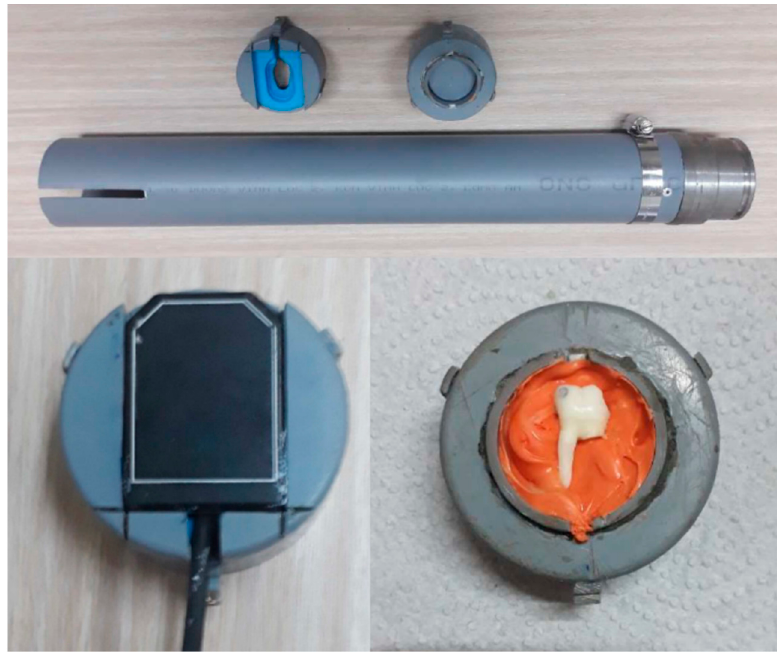
Figure 1. The device for periapical digital radiograph capture. Upper top: parts of the device with long plastic cone at the bottom; lower left: digital sensor in place; lower right: tooth with silicone impression in place.